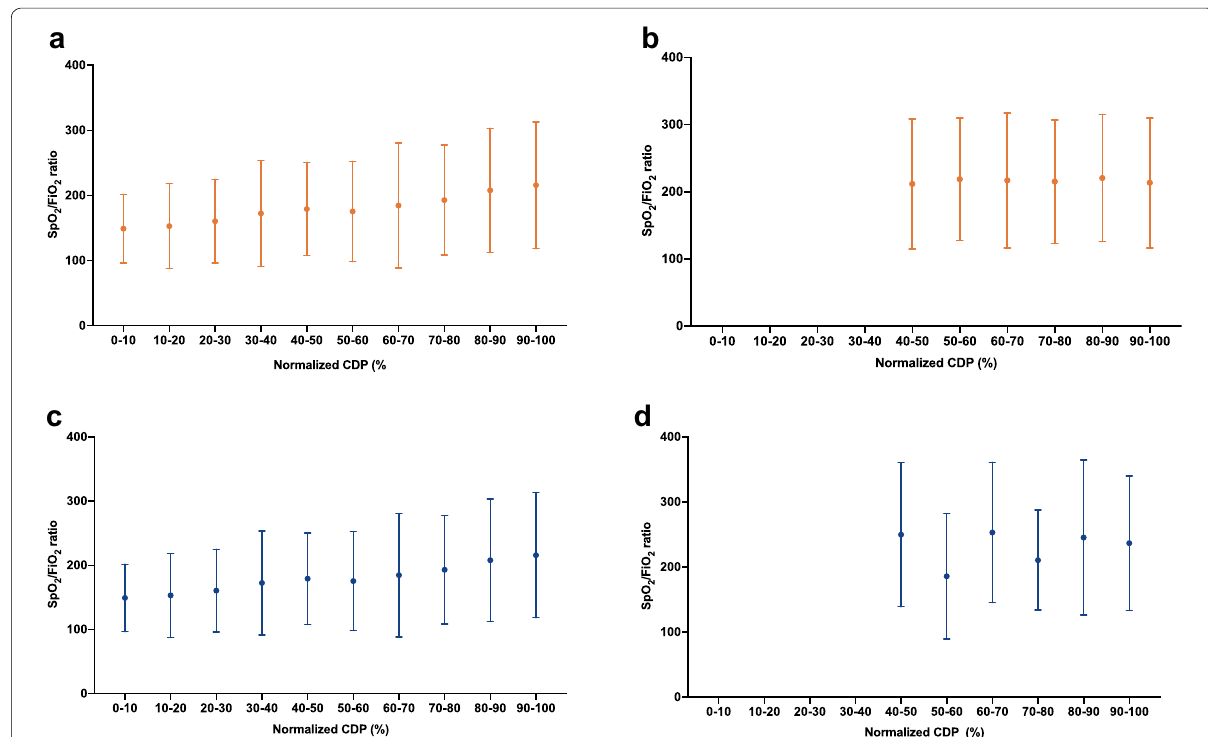
Fig. 1 Pooled SpO 2 /FiO 2 ratio for a given continuous distending pressure (CDP) normalized from 0 to 100% during the lung volume optimization maneuver incremental phase stratified by outcome, i.e., responsive (panel A and B, N presented as median and 25–75 interquartile range